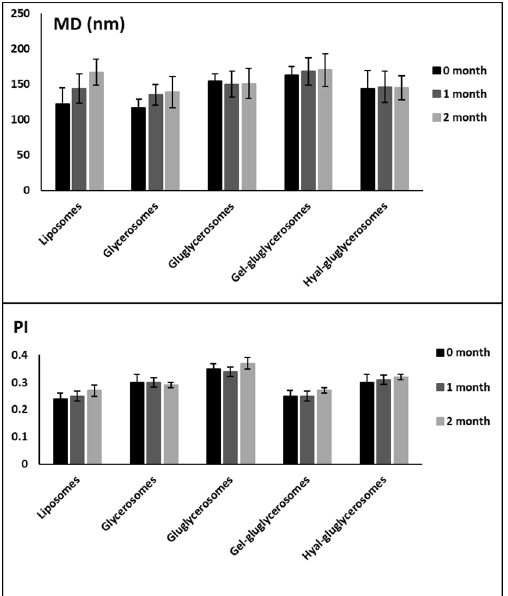
Figure 3. Mean diameter and polydispersity index (PI) of vesicles containing H. scruglii extract over 60 days of storage at room temperature (25 °C). Mean values ± standard deviations are reported (n = 6).